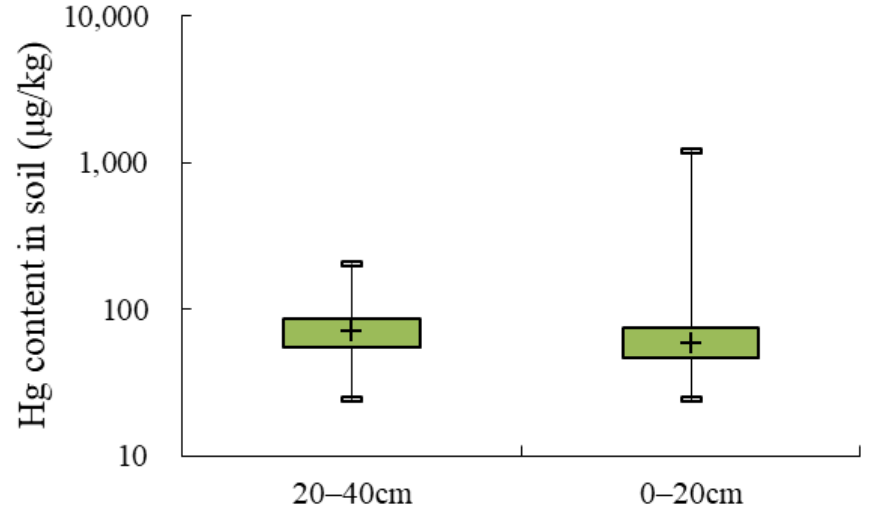
of 78.3 µ g/kg. In subsurface soil, the Hg content ranged from 24.4 to 202 µ g/kg, with an average of 75.2 µ g/kg.